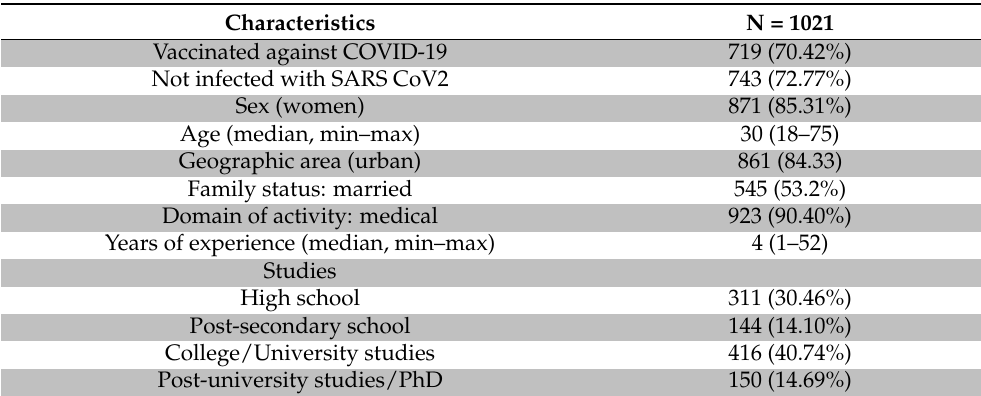
Table 1. Vaccination/infectious COVID-19 status and socio-demographic and educational character- istics of respondents to the questionnaire. Characteristics N = 1021 Vaccinated against COVID-19 719 (70.42%) Not infected with SARS CoV2 743